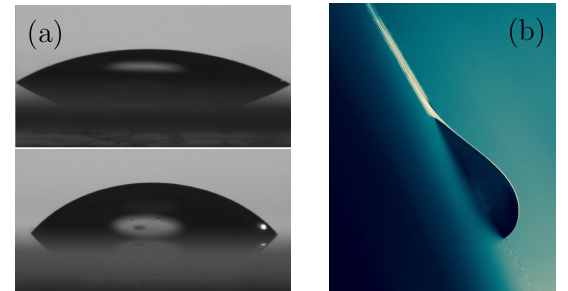
Figure 2: Water droplets – Contact angle of a 5 µ L water droplet on (a) the smooth side of the glass (top) and on the rough side of the glass (bottom). (b) Water droplet sliding along the rough side of the frosted glass. This illustrates the advancing contact angle (about 80 ◦ ) and the receding contact angle (0 ◦